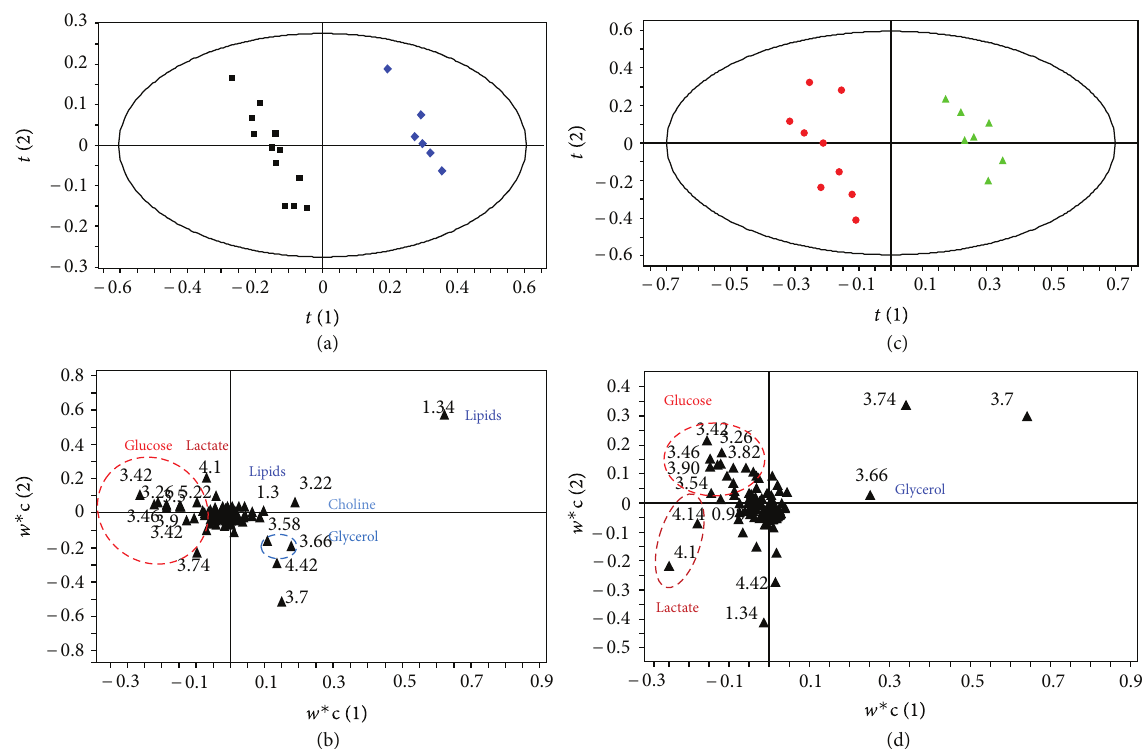
F 2: PLS-DA (a) score plot and (b) loading plot based on the ) and exposed female mice (black square, ). PLS-DA (c) score plot and (d) loading plot HNMR spectra of plasma samples from nonexposed (green triangle, based on the 𝑛𝑛 𝑛 𝑛 1 PLS-DA model Exposed Nonexposed